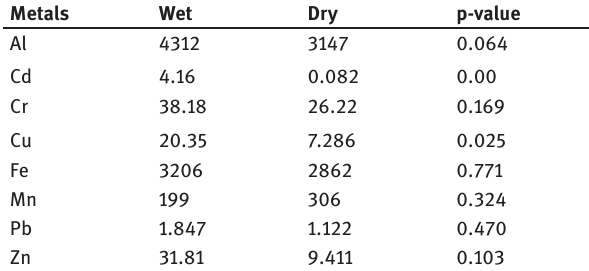
Table 2b: Mean concentrations of trace metal levels (mg/kg) in the wet and the dry season of Nzhelele River sediments and the difference in their means at p =